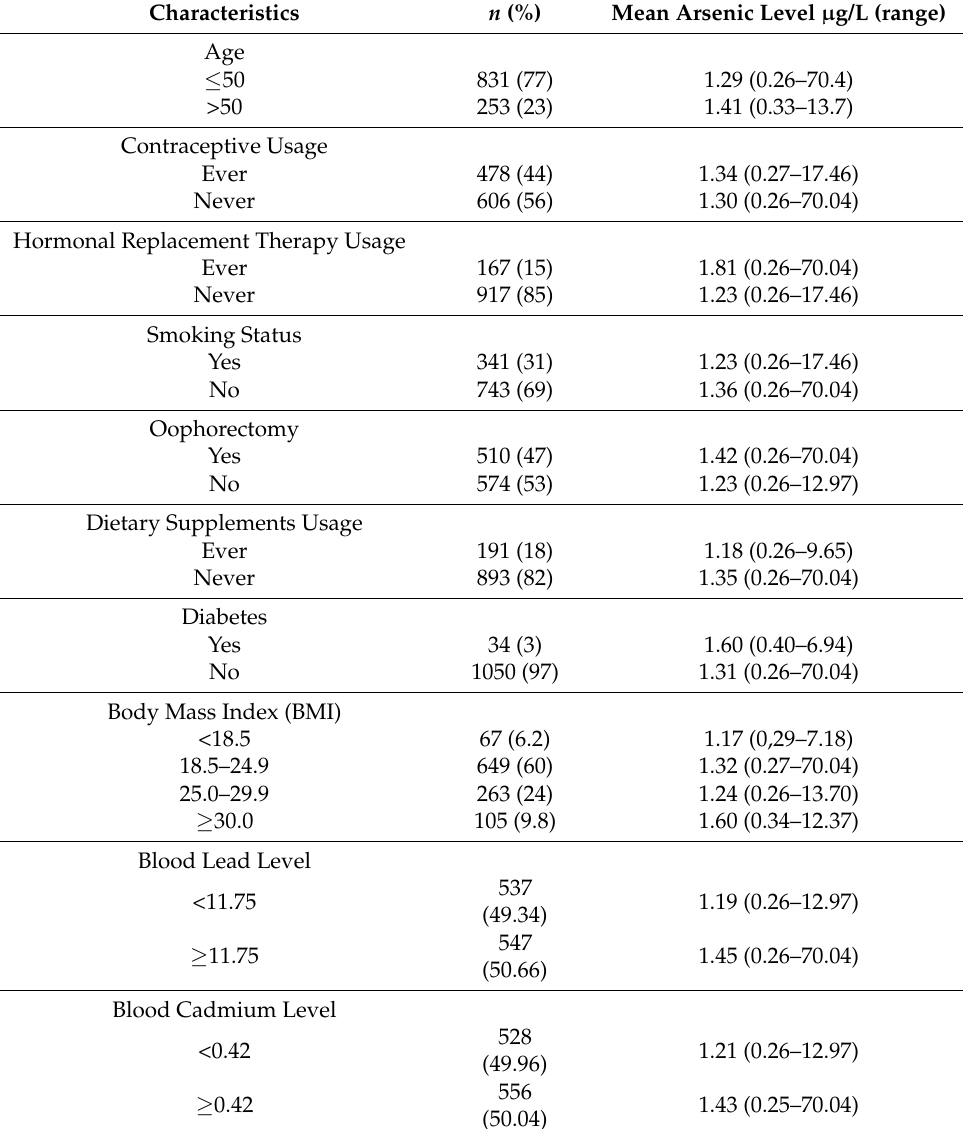
Table 1. Characteristics of 1084 women in the